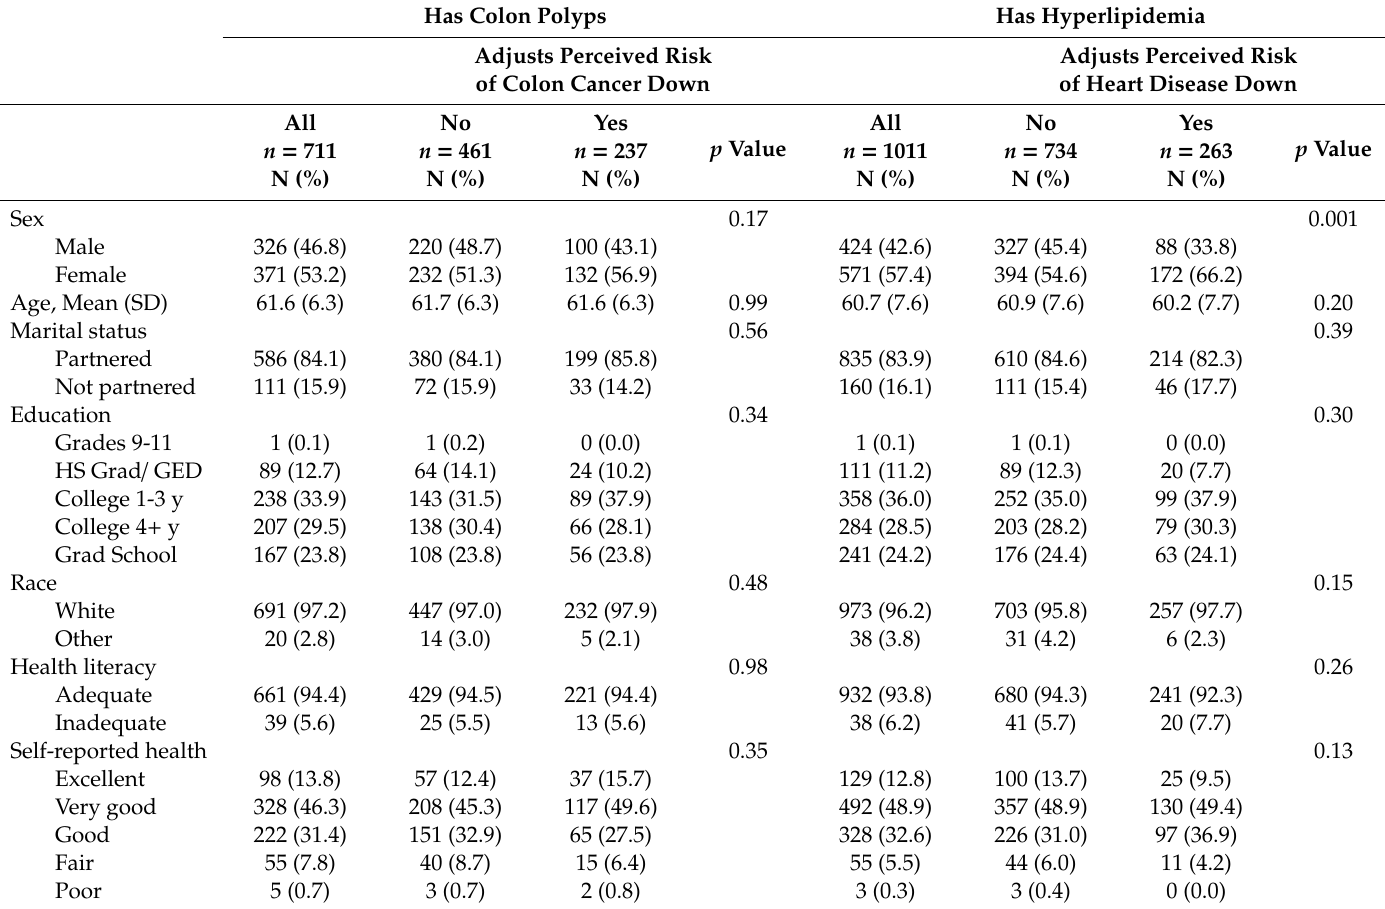
Table 3. Participants with at-risk phenotypes who did and did not adjust perceived risk down for colon cancer and heart disease. Has Colon Polyps Has Hyperlipidemia Adjusts Perceived Risk of Colon Cancer Down